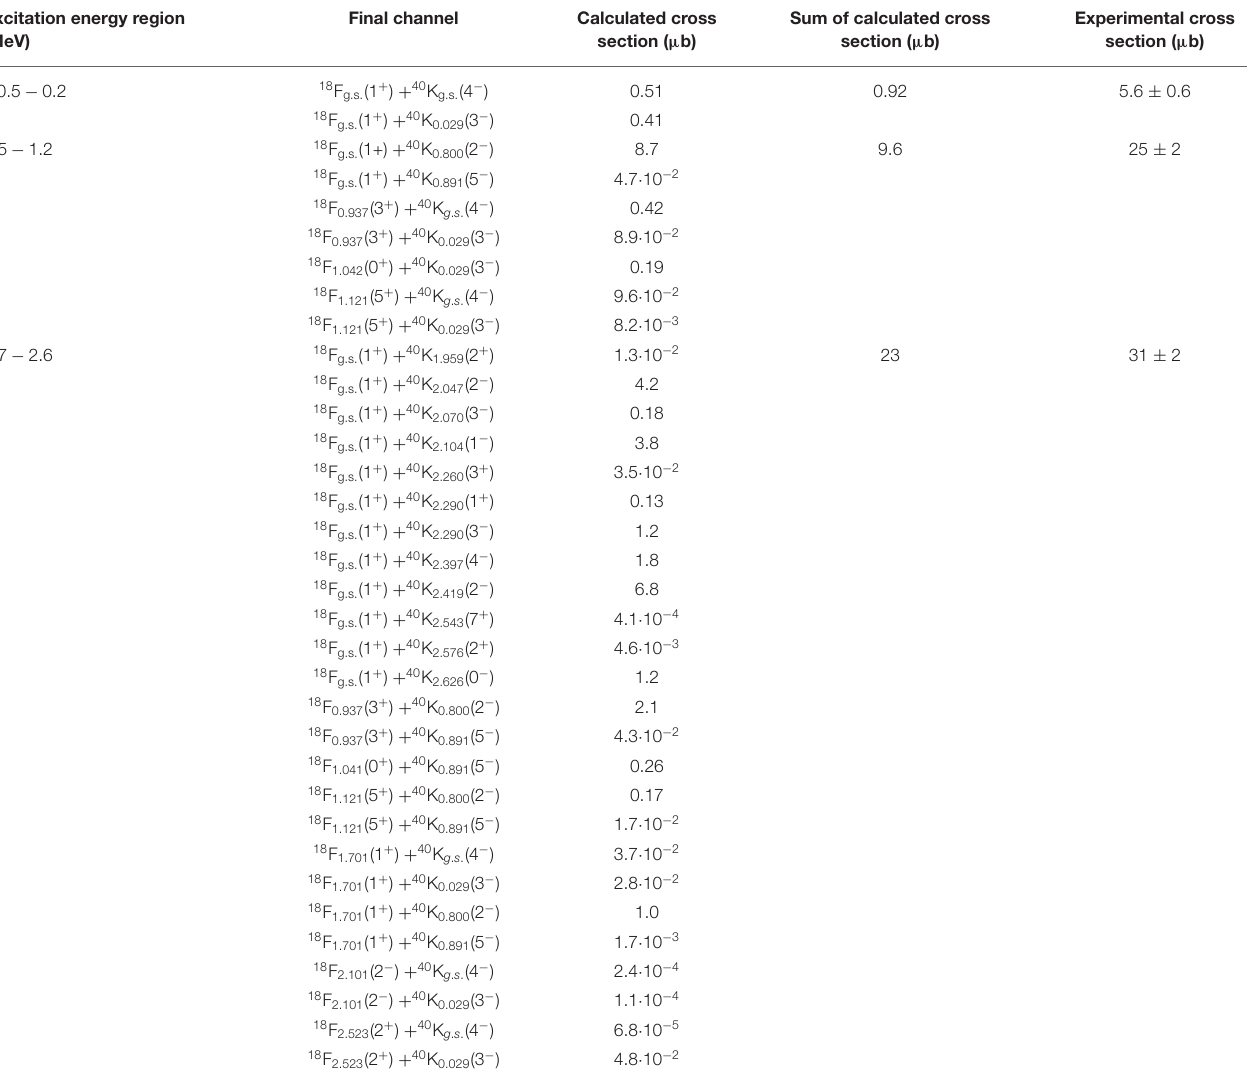
TABLE 1 | Transitions expected for the three regions of interest of the 40 Ca( 18 O, 18 F) 40 K energy spectrum as indicated in Figure 3 . Excitation energy region